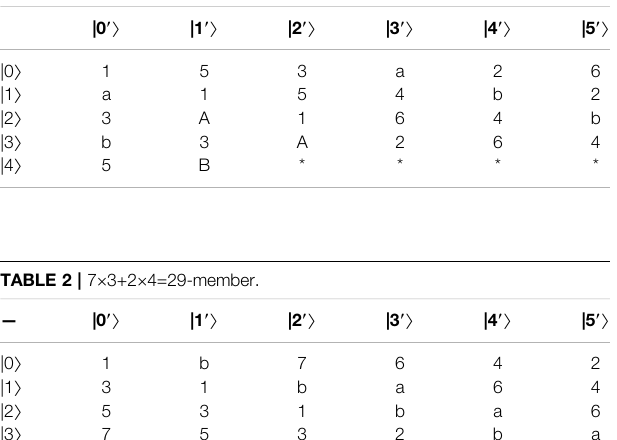
TABLE 1 | 6×3+2×4=30, − ,4=26-member UEB3.